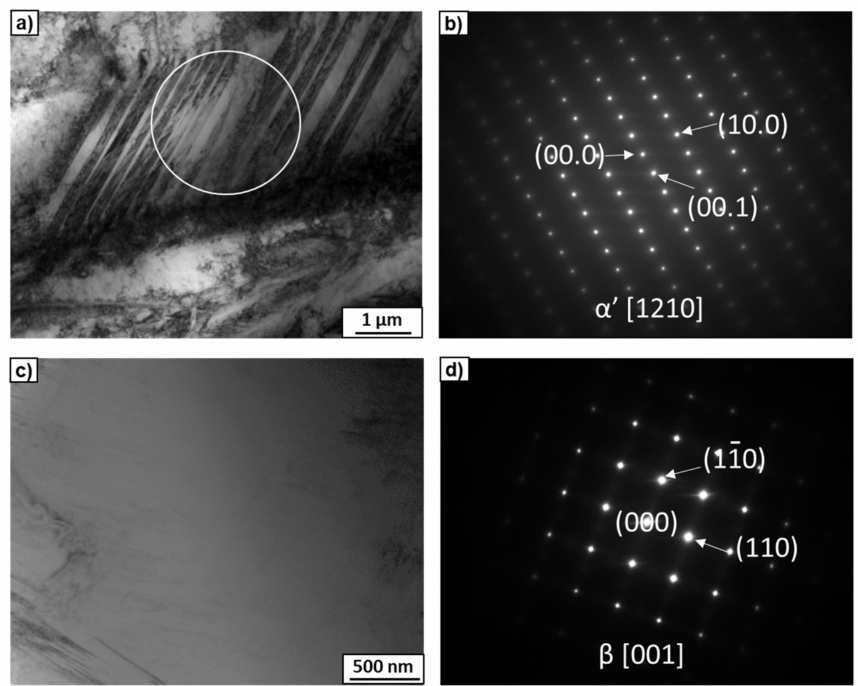
Figure 7. TEM micrographs of the Ti–2wt.% Mo ( a , b ) and Ti–18wt.% Mo ( c , d ) alloys after annealing at 1000 ◦ C. Bright-field images ( a , c ) with the SAED patterns ( b , d ) indicate α (cid:48) - and β -phases. The white circle marked in ( a ) shows the area from which the SAED pattern was obtained.